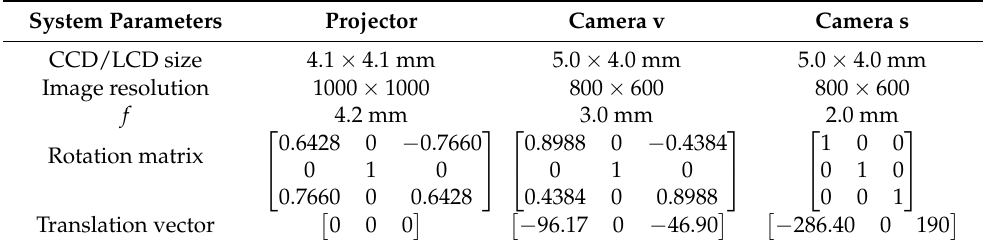
Table 1. System parameters of the projector, camera v and camera s. System